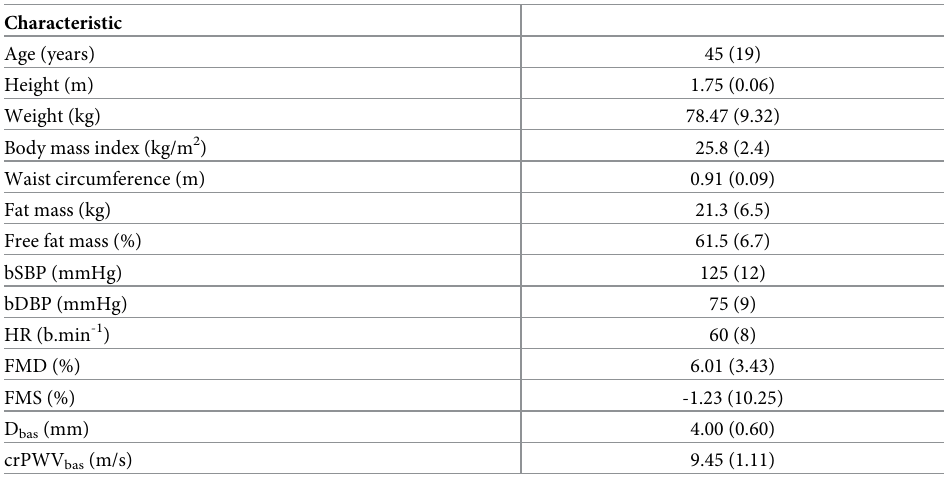
Table 1. Characteristics of the participants (n =